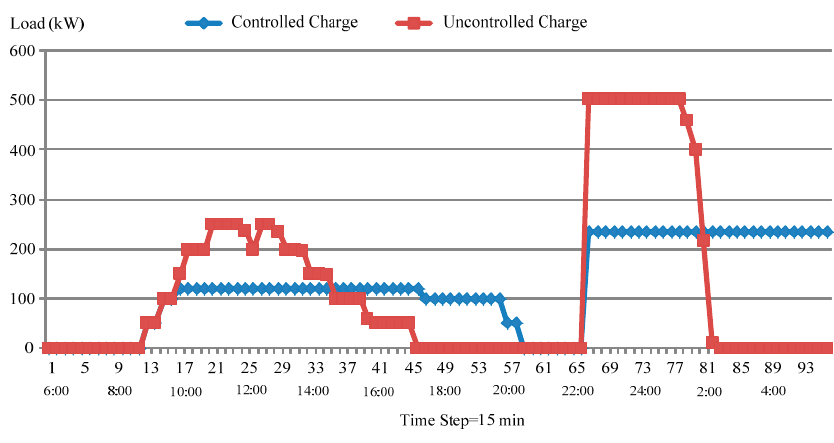
Figure 9. Charging schedule of uncontrolled charge of buses 1~7 for this iteration.